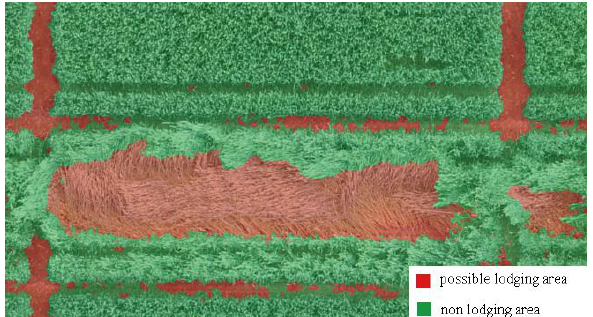
Figure 12. Lodging area detection from the UAV height